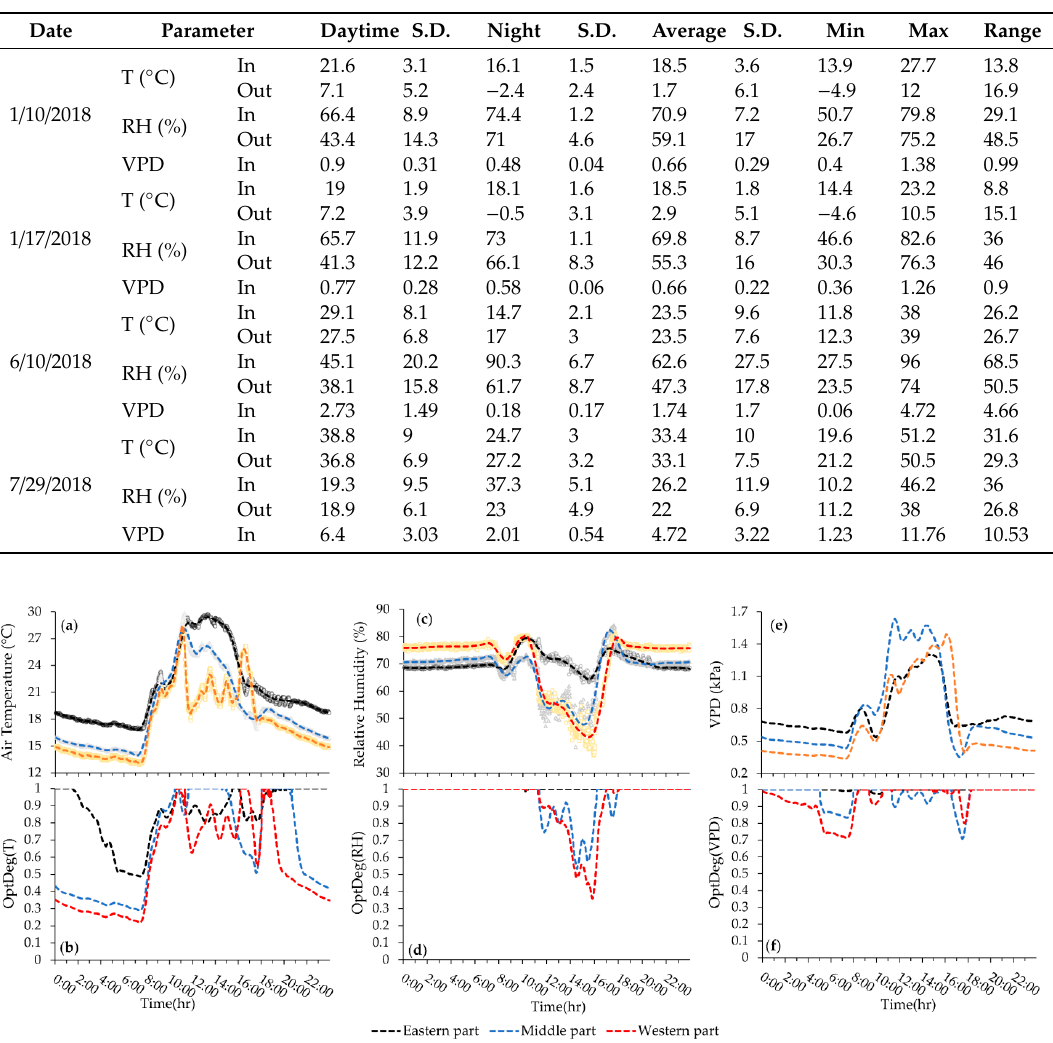
Table 4. Descriptive statistics summary of the air temperature, relative humidity and vapor pressure deficit in greenhouse and air temperature, relative humidity of surrounding environment. S.D.: Standard deviation.